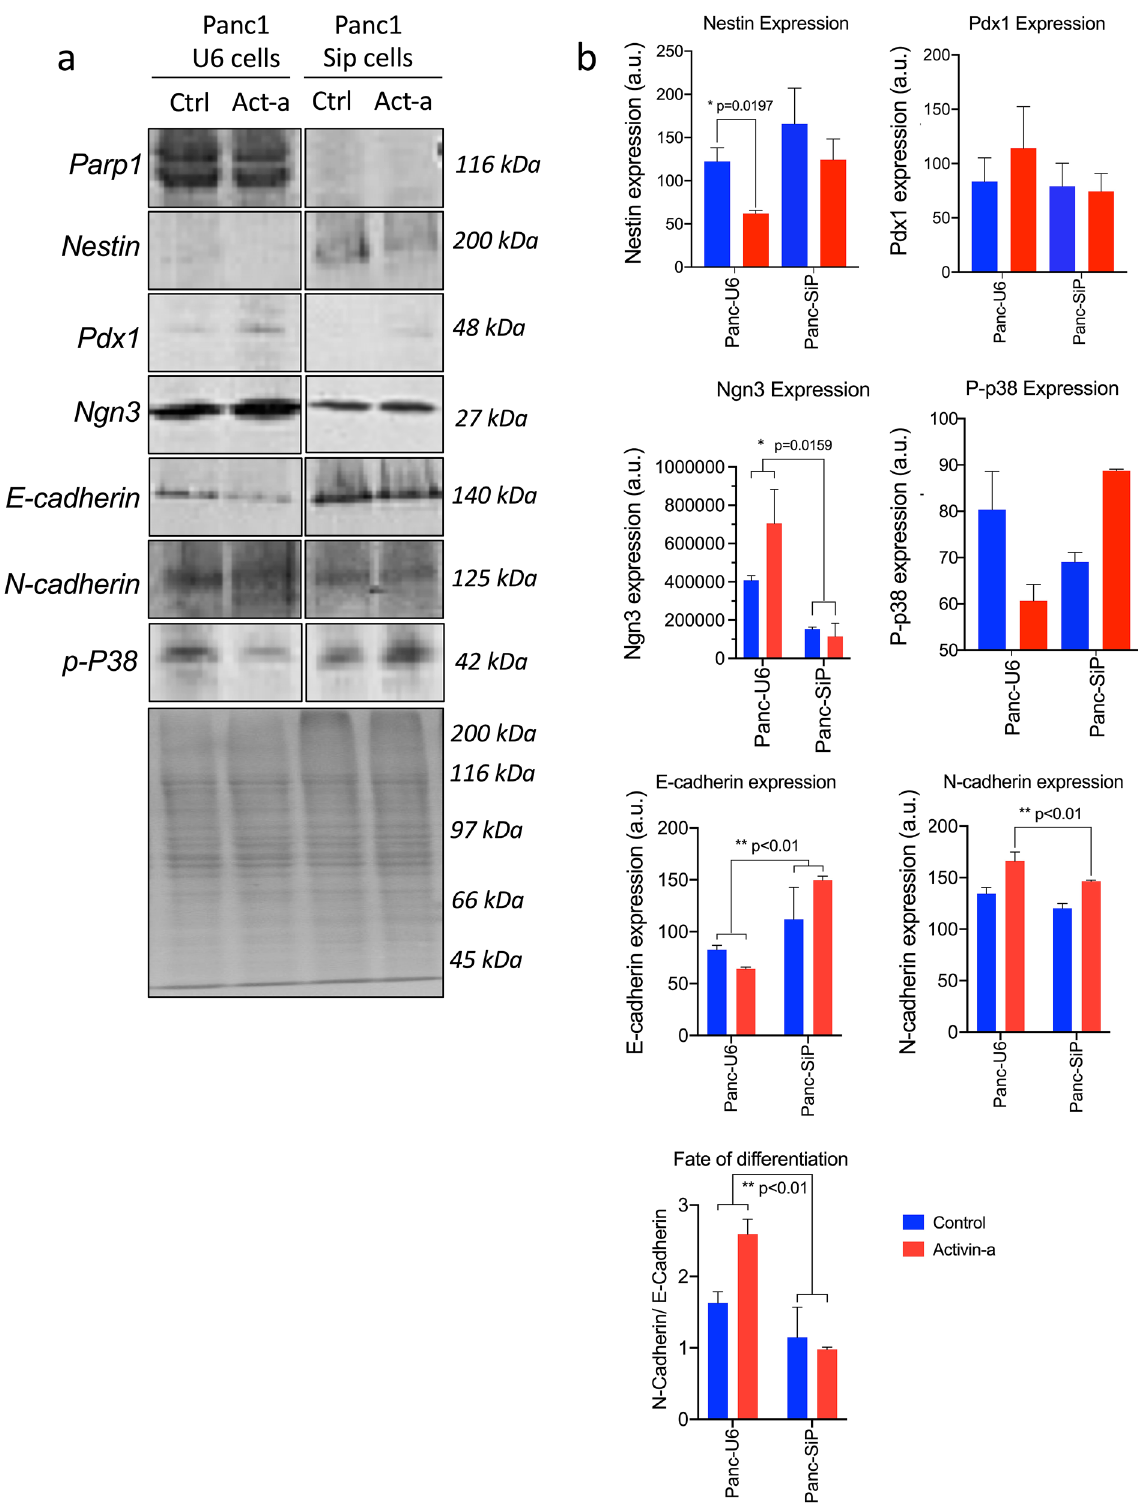
Figure 4. Molecular characterization and quantification of proteomic signals for efficient islet cell differentiation in PANC-1 U6 vs SiP cells. ( a ) Immunoblotting profile of PARP1 expression along with key pancreatic progenitor markers in SFM and activin-A induced differentiation in PANC-1 cells. ( b ) Quantification for endocrine reprograming transcription factors and ratio of progenitor (E-cadherin) states vs endocrine β cell (N-Cadherin) states. Data represented as mean ± sem, p-value show significance at 95% confidence interval using two-way anova analysis compared to U6 cells (n =